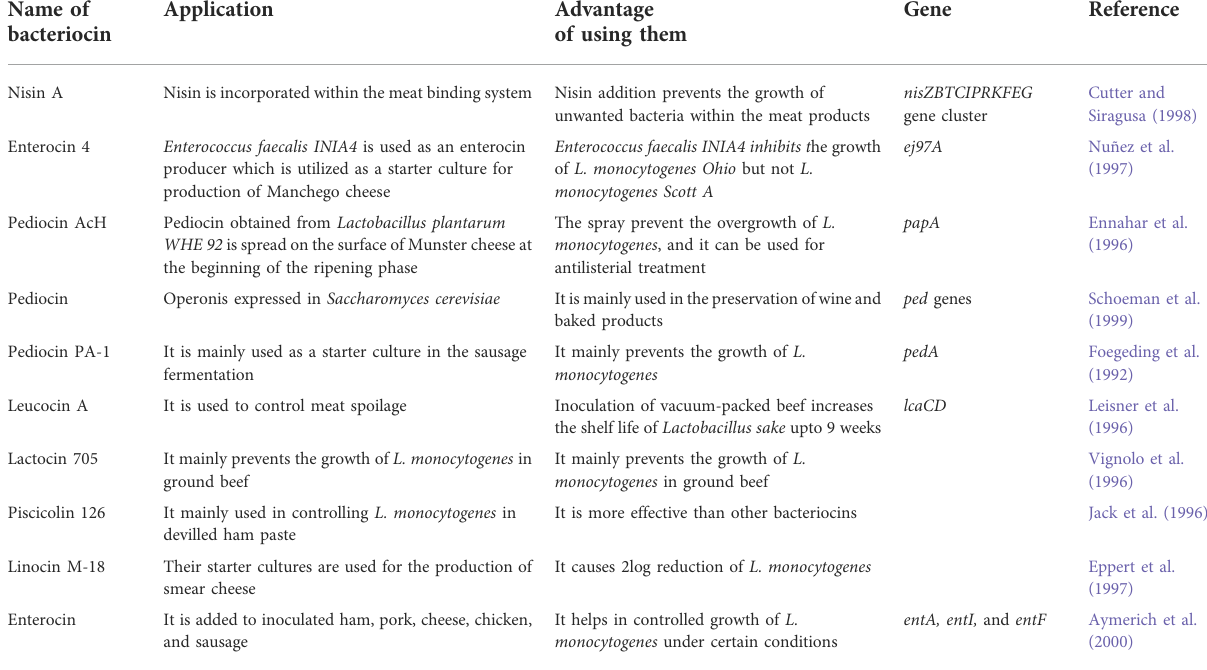
TABLE 2 Examples of bacteriocin as a food